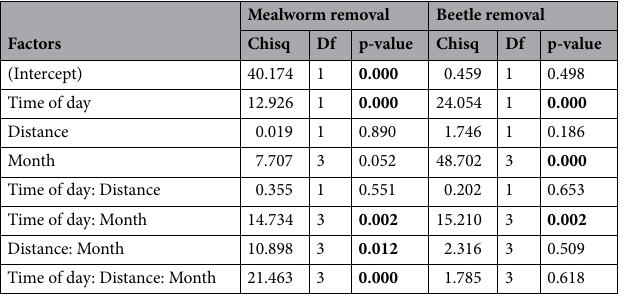
Table 1. Analysis of Deviance Table (Type III Wald chi-squared tests) for mealworm and beetle predation, showing the chi-squared statistic (Chisq), degrees of freedom (Df) and p-value. Significant probabilities are shown in bold.